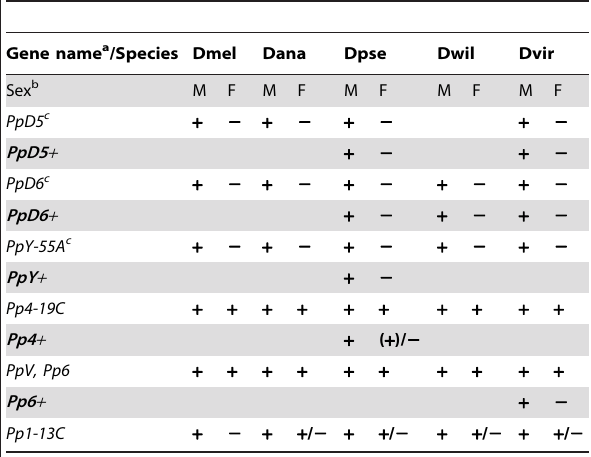
Table 3. Expression of the new PPP genes in Drosophila